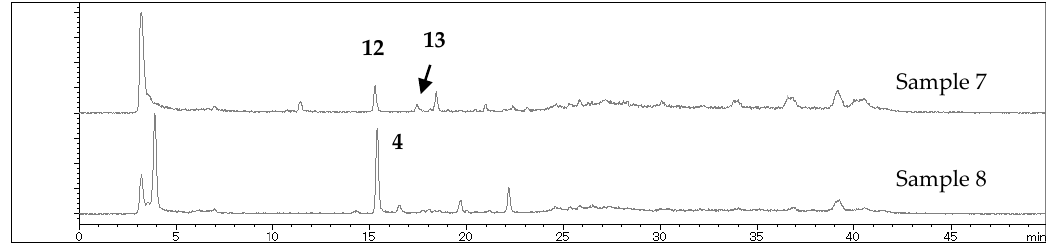
Figure 4. LCMS profile (total ion chromatogram) of samples 7 and 8. See Figure S5 for samples 1–6 and 9.